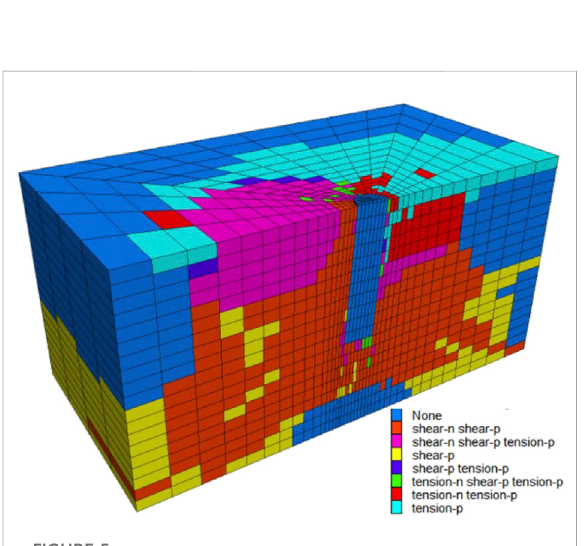
FIGURE 5 Zone state for thereference case after deviation recti fi cation.